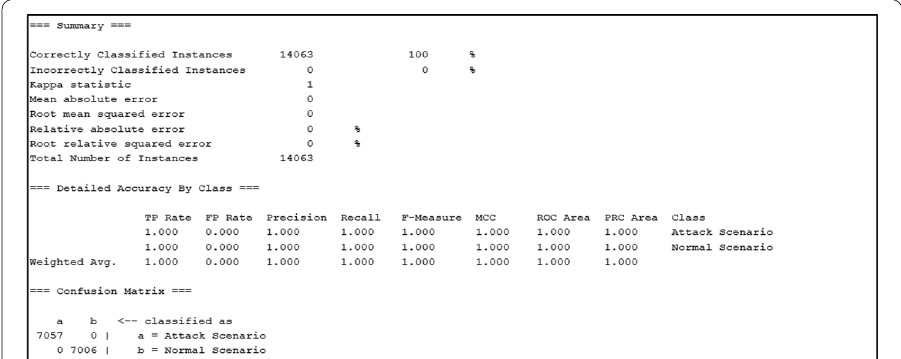
Fig. 3 Detailed Accuracy for Training Dataset using Logistic Machine Learning